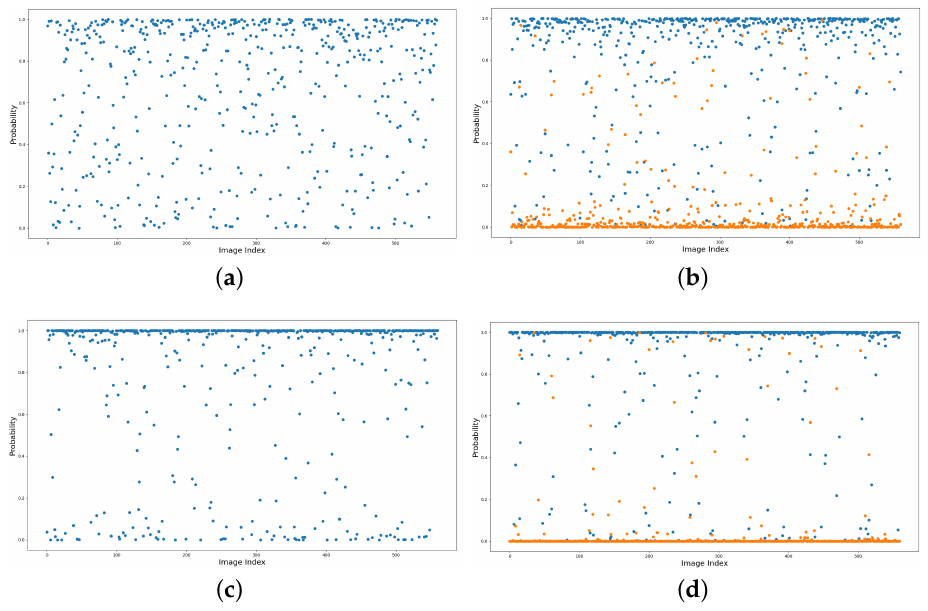
Figure 5. An exemplar demonstration of the intra-class variance and inter-class similarity. The figures plot the output scores by ResNet-50 in ( a , b ) and that by our method in ( c , d ) for all images in the NWPU-RESISC 45 dataset. In ( a , c ), the blue points represent the predicted church probability of each image belonging on the true church class. In ( b , d ), the blue and yellow points represent the predicted probabilities on dense residential and medium residential, respectively, where the images actually belong to the dense residential